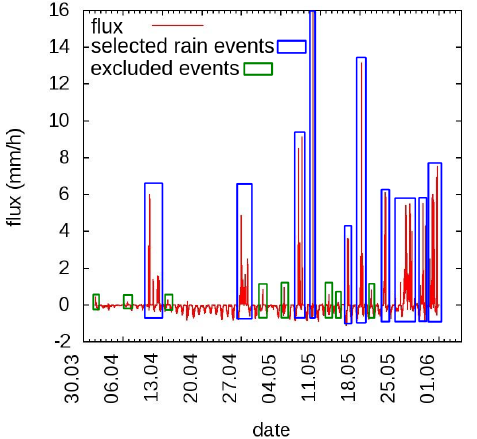
Figure 10. Selection of periods for the investigation of the noise and the mixing error. The purple periods were selected for the estimation of the mixing error, the blue periods of light rain were excluded because of the contribution to both errors, and the rest of the data set was used for the estimation of the noise error.